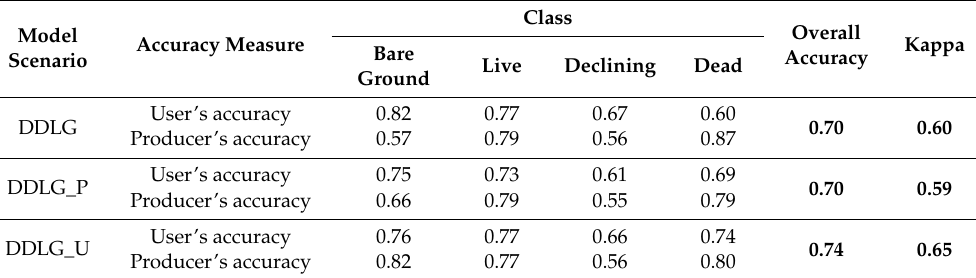
Table 8. Results of the validation on an independent stratified random sample of 750 pixels per class for the three classification scenarios: Random forest (RF) classification (DDLG), RF classification with post-processing (DDLG_P), and with deadwood-uncertainty filter (DDLG_U). Presented are producer’s, user’s, and overall accuracy, as well as Cohen’s Kappa (the last two indicated in bold). Detailed confusion matrices with the amount of validated pixels per class are shown in Table